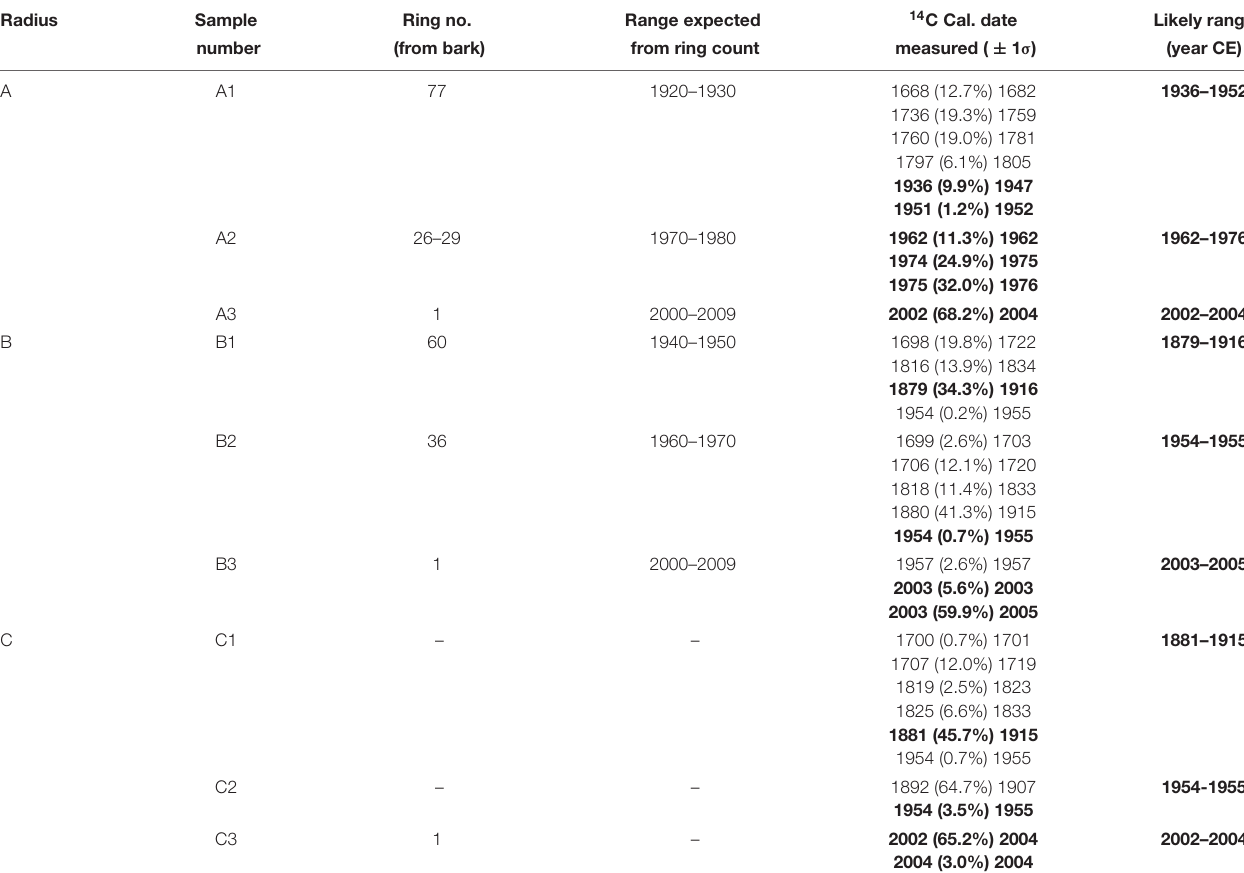
TABLE 1 | Ring count and corresponding radiocarbon date range ( ± 1 σ